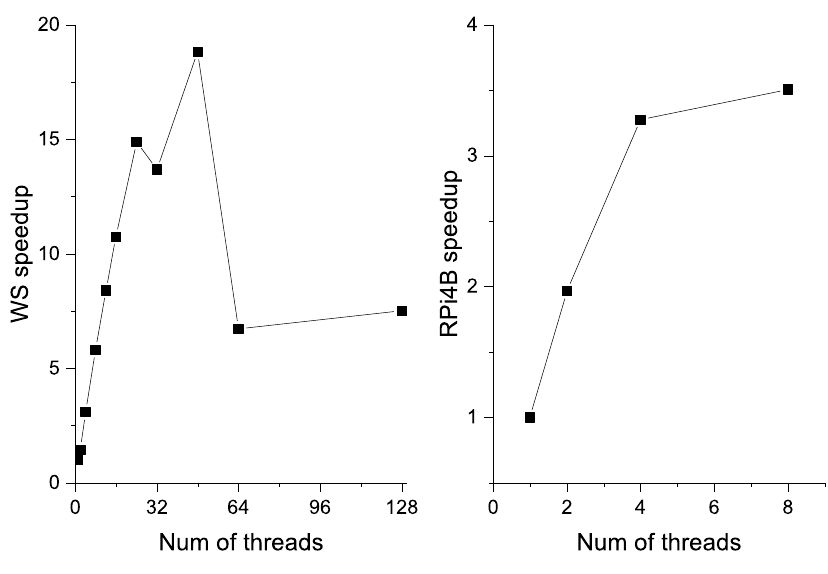
Figure 8. Speedup in multi-CPU mode for WS and RPi4B. According to the speedup results, WS performs best for 48 threads. Small performance drop can be noticed using 32 threads instead of 24 (physical cores). In order to execute tasks efficiently on WS, the scheduler should assign CA computations on 24 or 48 threads. In the case of RPi4B, the best performance is obtained for 8 threads. However, the difference between 4 and 8 threads is very small and executing task with this overhead can in the end lead to thermal